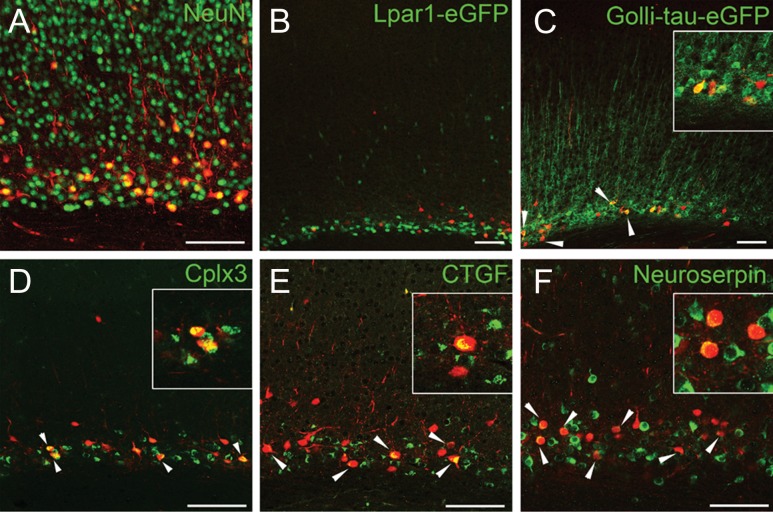

Drd1a-Cre::tdTom+ neurons co-express Cplx3, CTGF and Neuroserpin, but do not co-localize with Lpar1-eGFP at P8. (A) Drd1a-Cre::tdTom+ cells are NeuN+ neurons, and co-express Cplx3 (D), CTGF (E) and Neuroserpin (F; arrowheads). Drd1a-Cre::tdTom+ cells overlap with Golli-tau-eGFP+ cells in triple transgenic brains (C, arrowheads). Drd1a-Cre::tdTom+ cells do not overlap with Lpar1-eGFP+ cells in triple transgenic brains (B). All images are from primary somatosensory cortex. Insets show examples of co-localization at higher magnification. Scale bars = 100 μm.